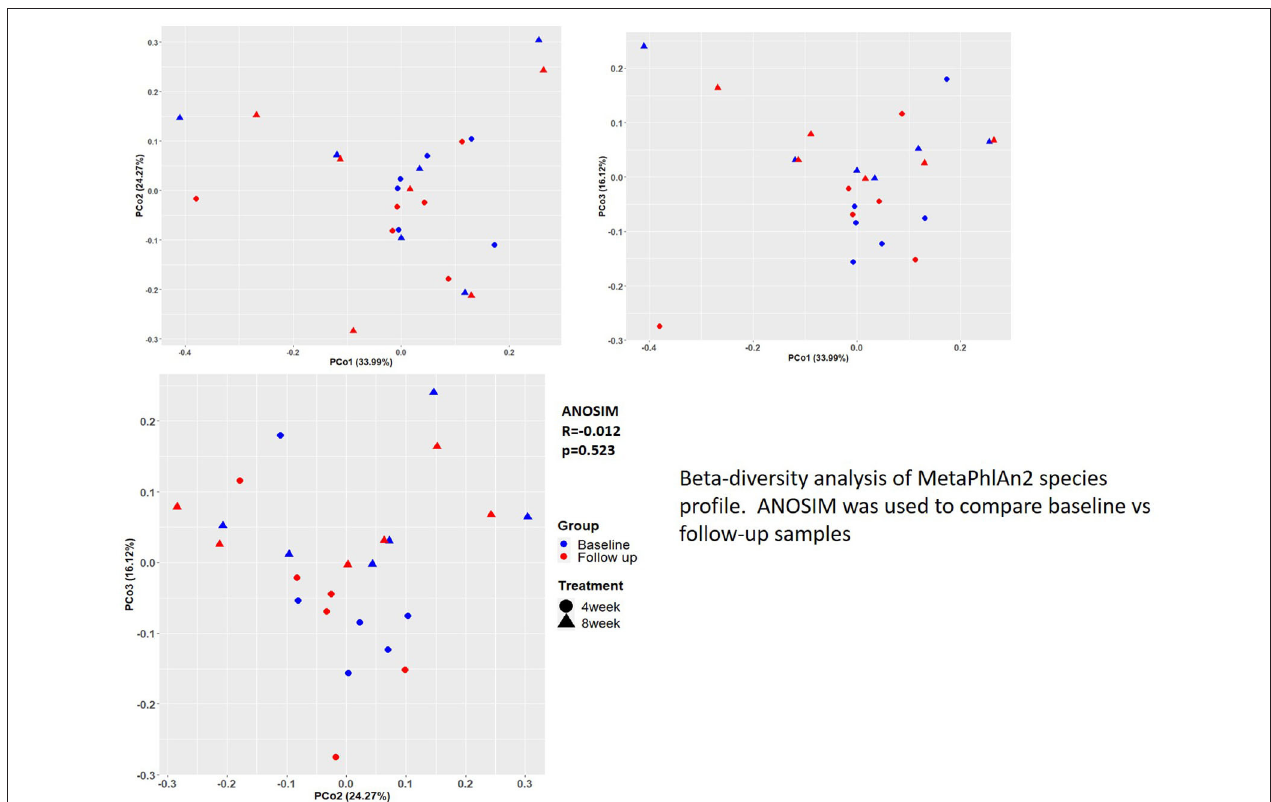
FIGURE 4 | Beta-diversity analysis of MetaPhlAn2 species profile. ANOSIM was used to compare baseline vs. follow-up samples.